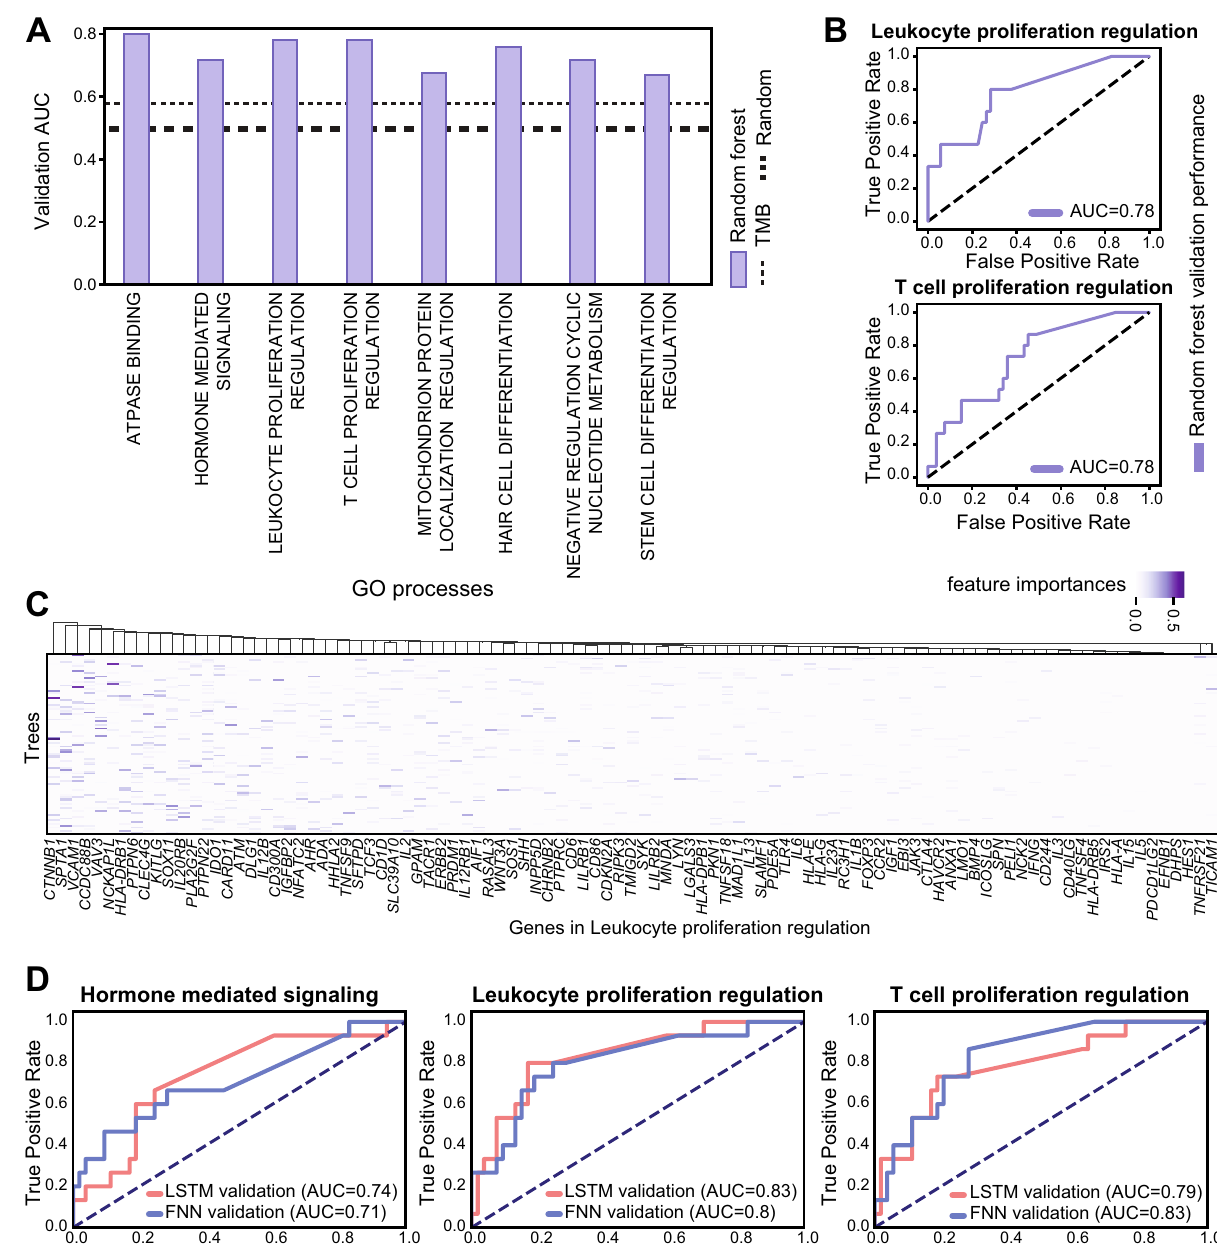
mutations in the leukocyte-proliferation regulation process. The values denote feature importance, by mean decrease in impurity. D ROC curves demonstrating the validation performances of two neural network architectures (LSTM and FNN) when trained on mutations within the hormone-mediated signaling process (left panel), leukocyte-proliferation regulation process (middle panel), and the T-cell proliferation regulation process (right panel). Source data are provided as Source Data